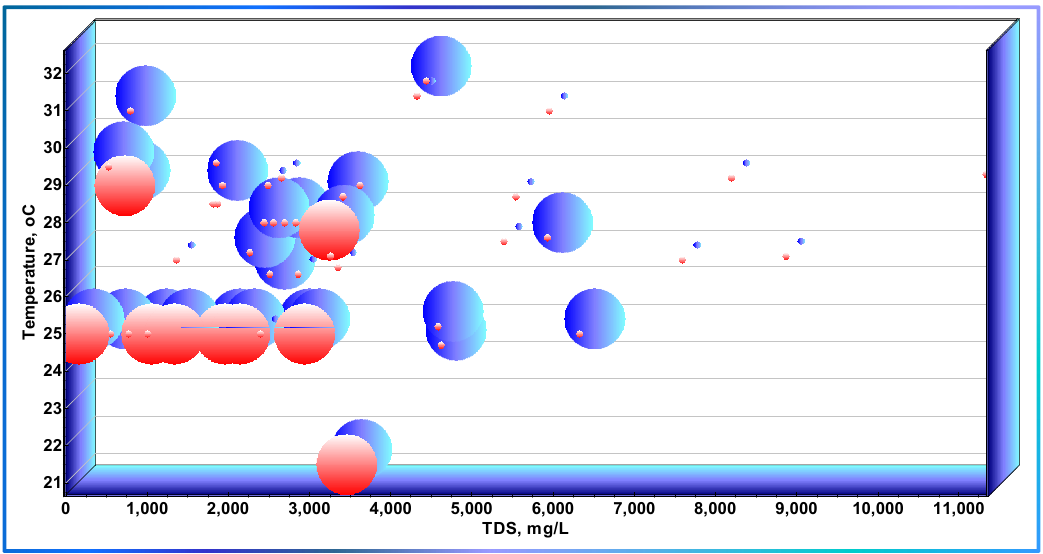
Figure 5. Bubble plot of the TDS and Temperature combined interaction on TC ( blue ) and E. coli ( red ).